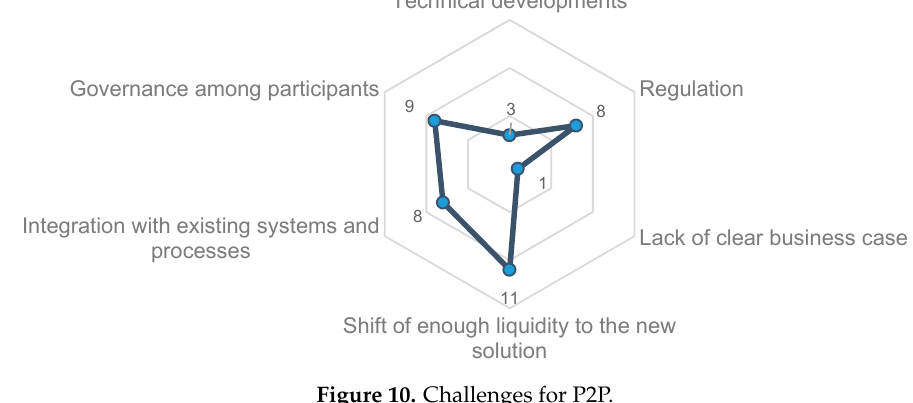
Figure 10. Challenges for P2P.